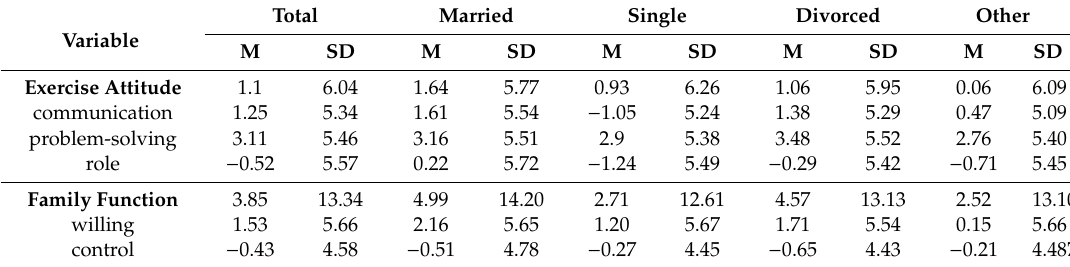
Table 2. Group di ff erences in exercise attitude and family function by marital